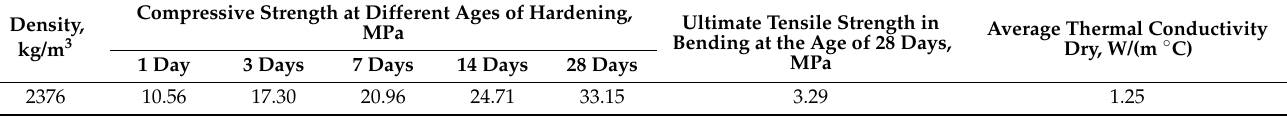
Table 2. The properties of heavy